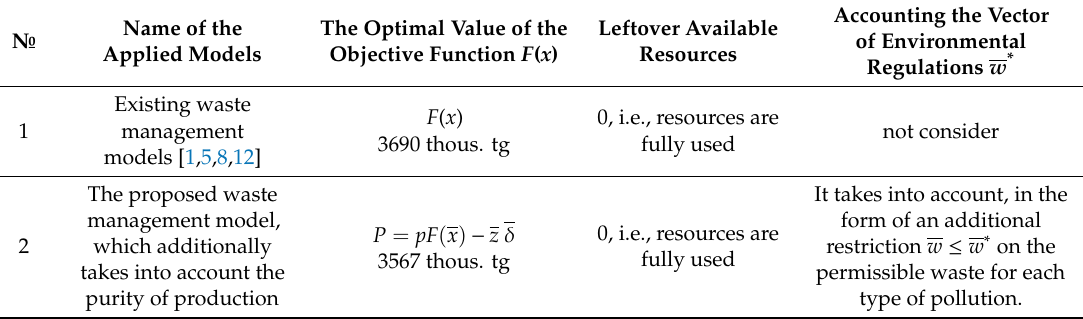
Table 1. Comparison of the results of using the known models and the proposed waste management model in solving the problem of optimizing the waste of the Atyrau refinery’s primary